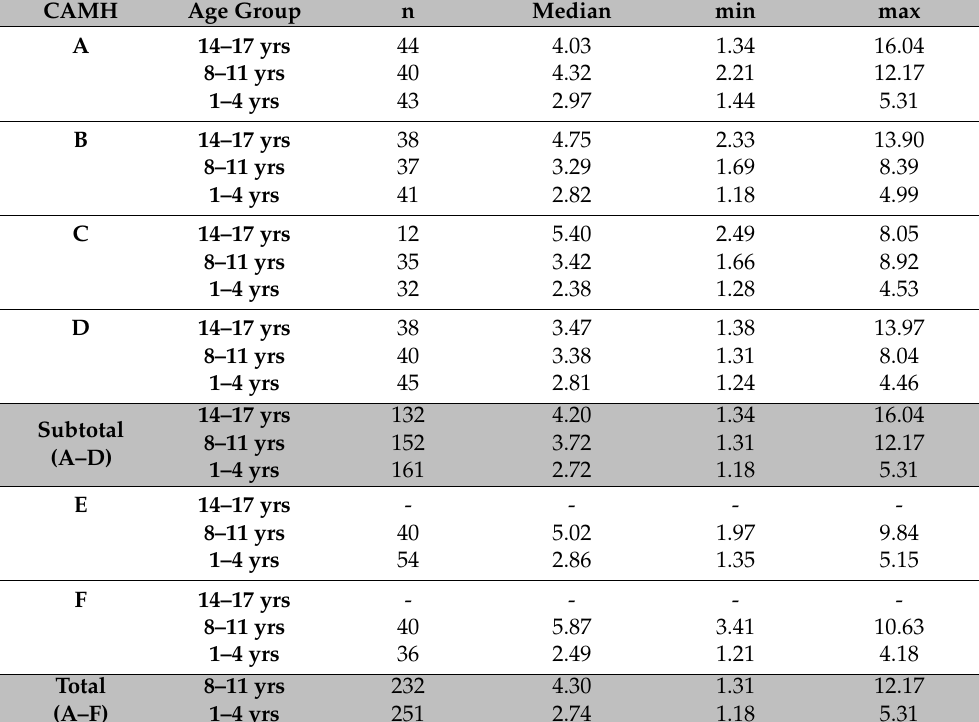
Table 5. Age at diagnosis (median and range: min–max) of subjects by CAMH unit and age groups.